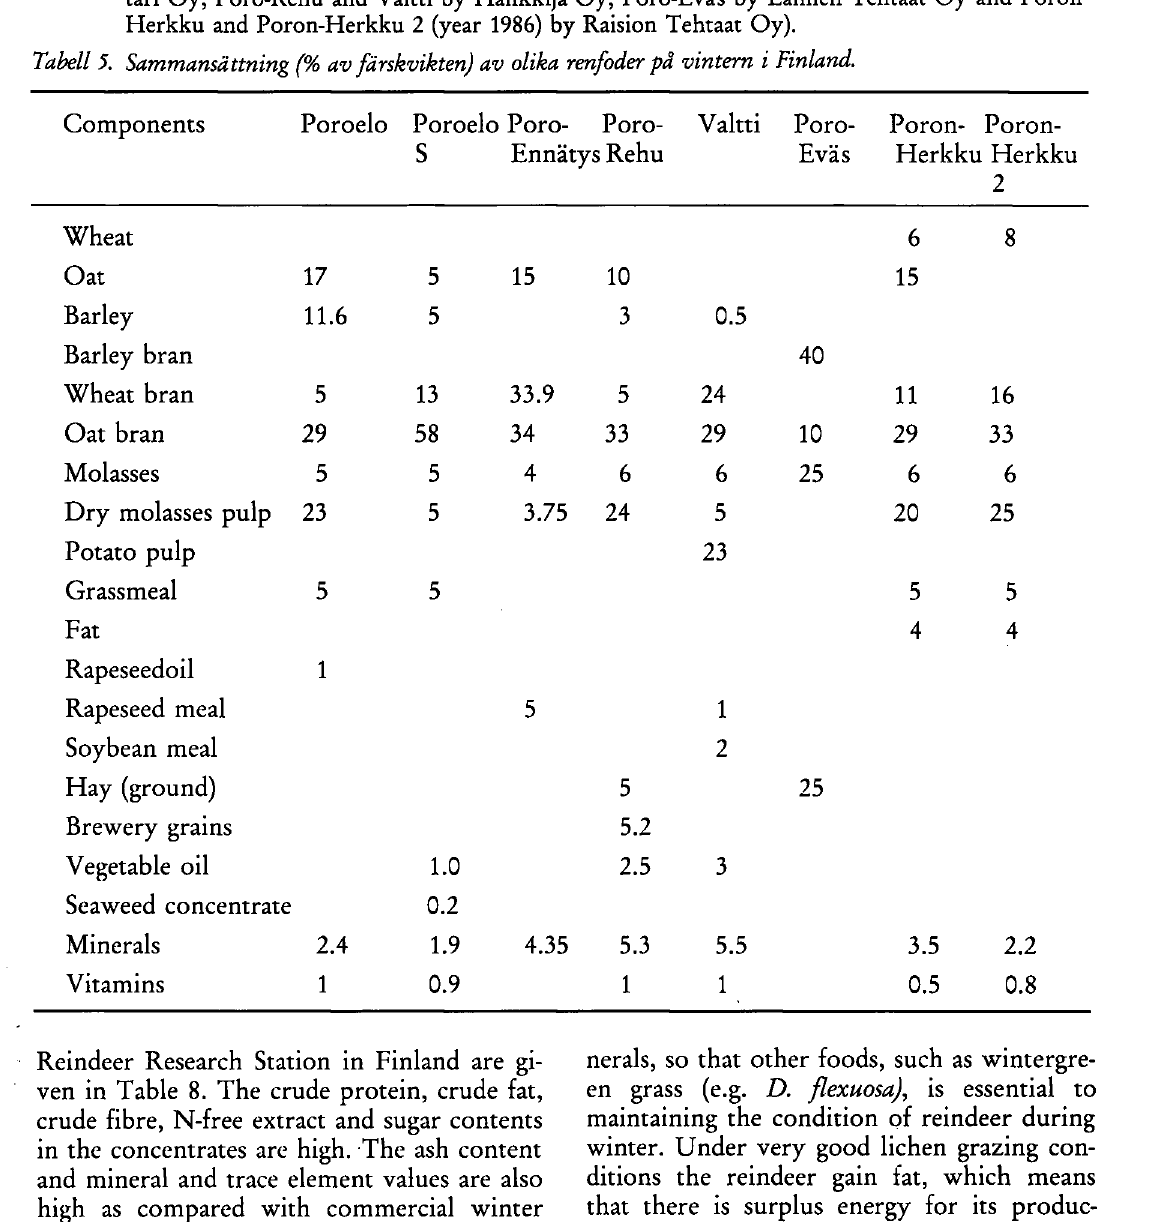
Table 5. The feed components (% fresh weight) of the commercial reindeer fodders used in Finland du ring winter (Poroelo and Poroelo S produced by Suomen Rehu Oy, Poro-Ennatys by Rehumes- tari Oy, Poro-Rehu and Valtti by Hankkija Oy, Poro-Evas by Lannen Tehtaat Oy and